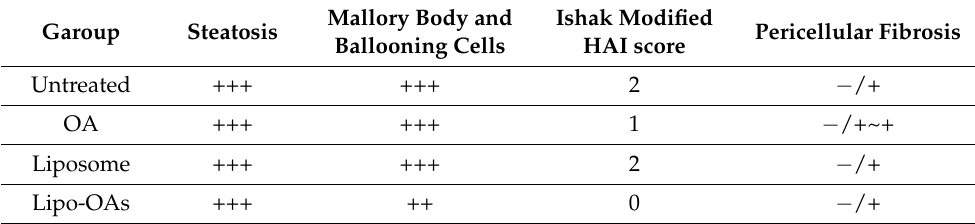
Table 4. Histological findings and scores after 6 treatment weeks in PM 2.5 - and alcohol-induced inflammation